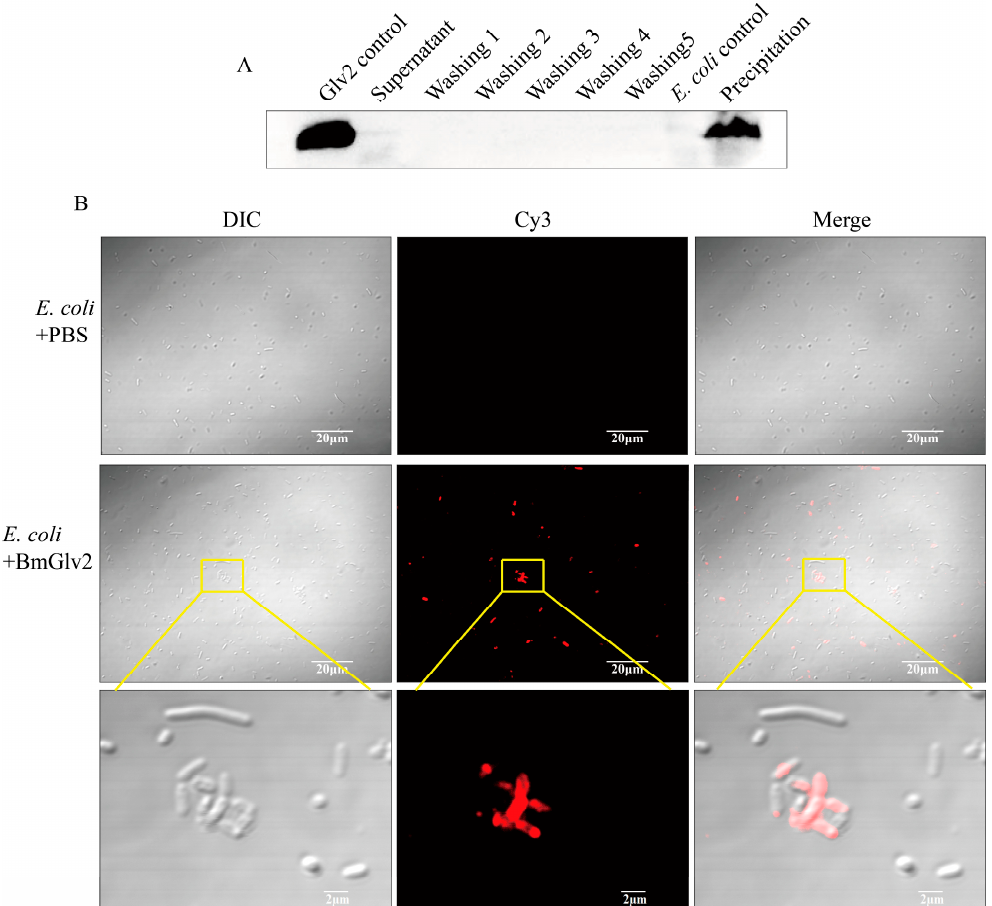
Figure 6. The binding activity analysis of recombinant BmGlv2 . ( A ) Western Blotting analysis of the binding of BmGlv2 to E. coli JM109 cells. Glv2 control, recombinant Glv2; Supernatant, a